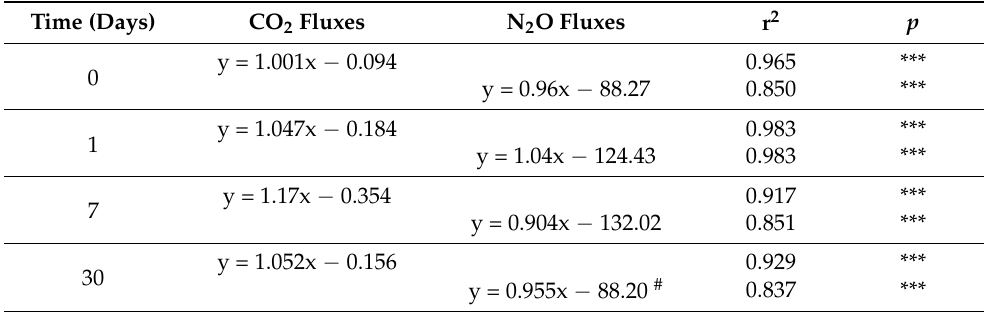
Table 1. Correlations between total and plant-mediated CO 2 and N 2 O fluxes across all treatments in experiments conducted on G. tinctoria at UCD’s Rosemount Environmental Research Station glasshouse, Dublin, Ireland, July–August 2017. Legend: 0, 1, 7, and 30 refer to before, 1, 7, and 30 days after the application of treatments; *** indicates p < 0.001; # indicates the exclusion of one outlier from the analysis.